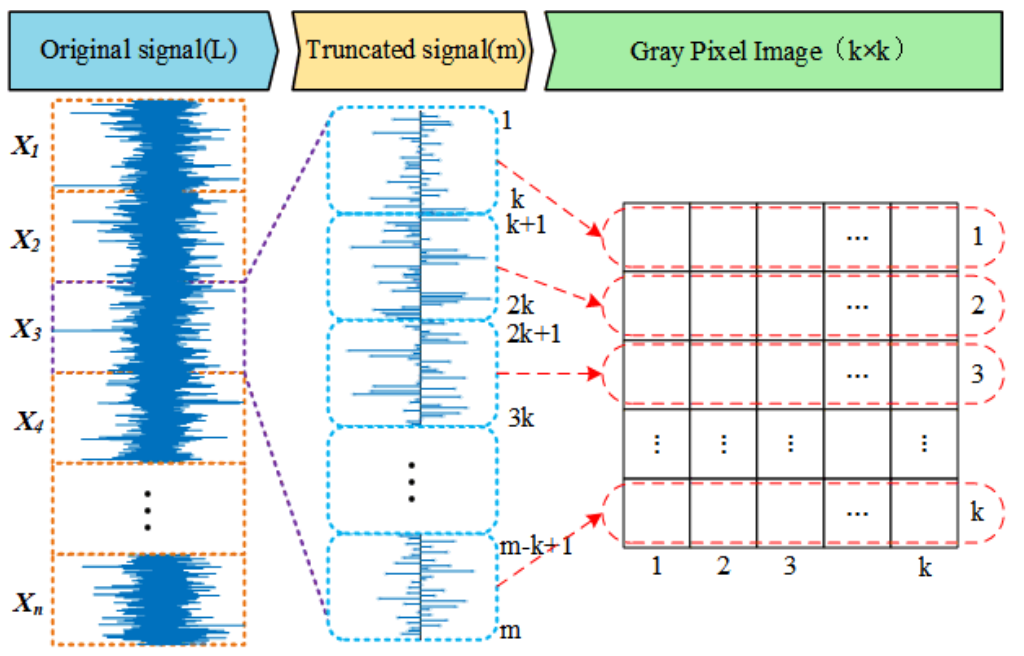
Figure 2. Signal-to-image conversion